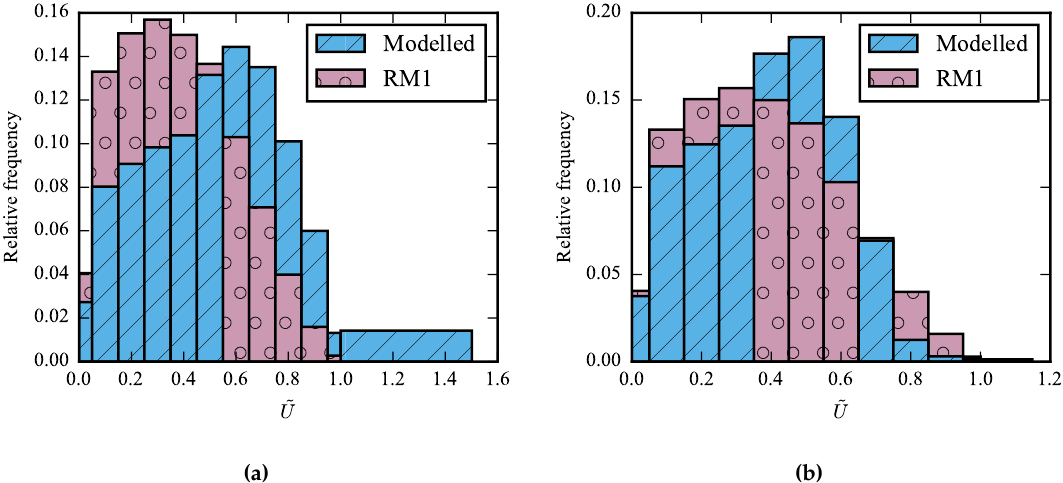
Figure 9. Comparative relative frequency histograms of [22, fig. 3-5] and all points within the Delft3D simulation of the Puget sound ( ˜ U = 3ms − 1 ) . The comparison prior to scaling is shown in (a) and following scaling in (b).